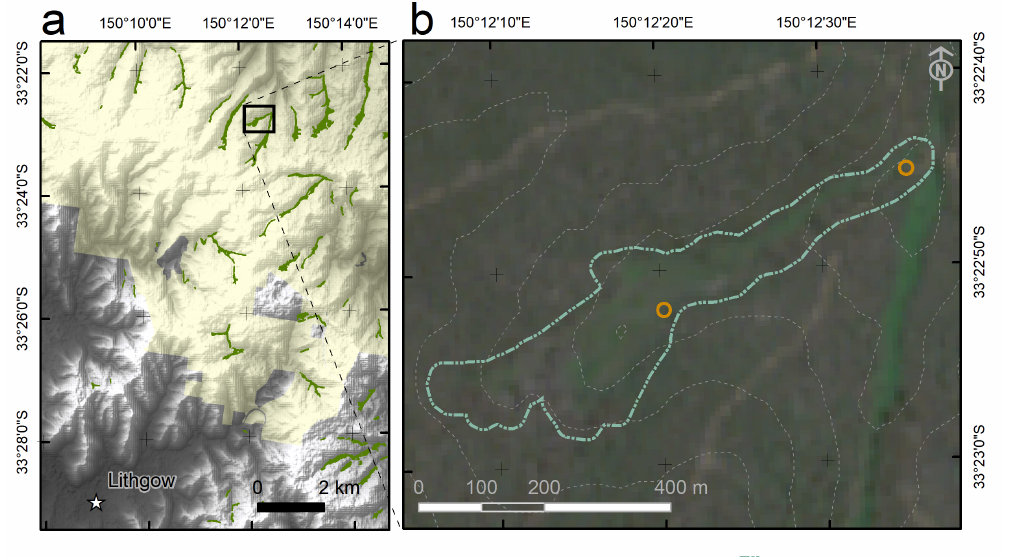
Figure 2. ( a ) Location of the study site relative to Lithgow, Newnes State Forest, and other mapped shrub swamp communities shown with a hillshade digital elevation model (USGS Shuttle Radar Topography Mission v2). ( b ) Study site extent showing launch and landing areas and 10 m contours. Background true colour Sentinel 2 imagery acquired 14 February 2018 (Credit: European Union Sentinel Data).